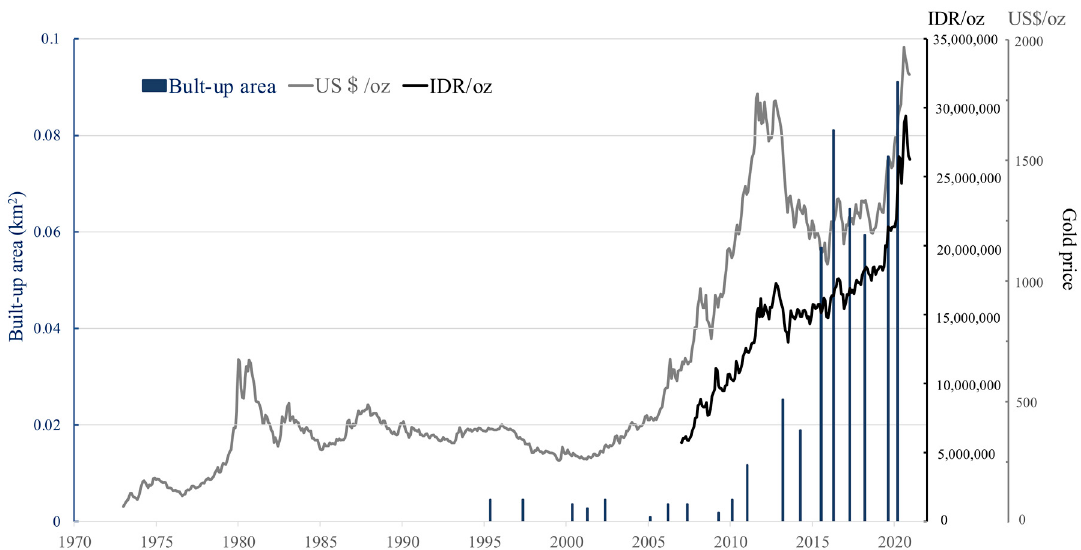
Figure 8. Global gold price, Indonesian gold price, and built-up areas in the